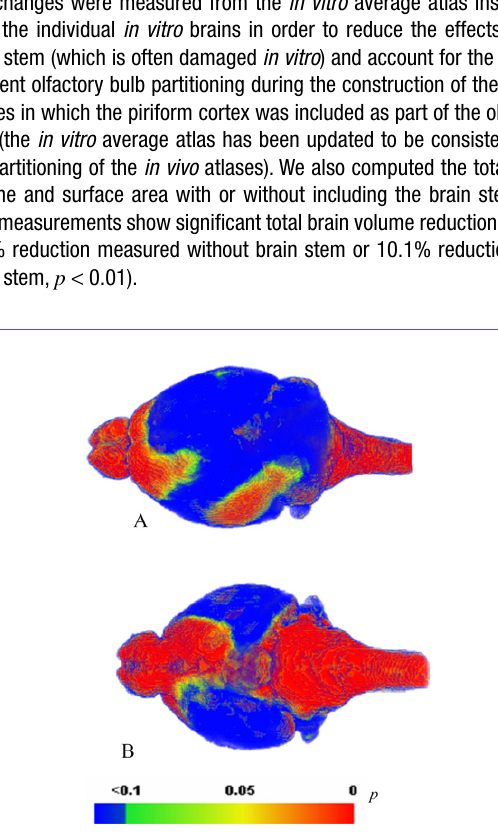
Figure 9. 3D views of the p -values resulted from the voxel-wise unpaired t -test between the deformation maps of the in vivo group ( n = 12, Figure 8B) versus the in vitro group ( n = 10, Figure 8C). (A) Dorsal view. (B) Ventral view.